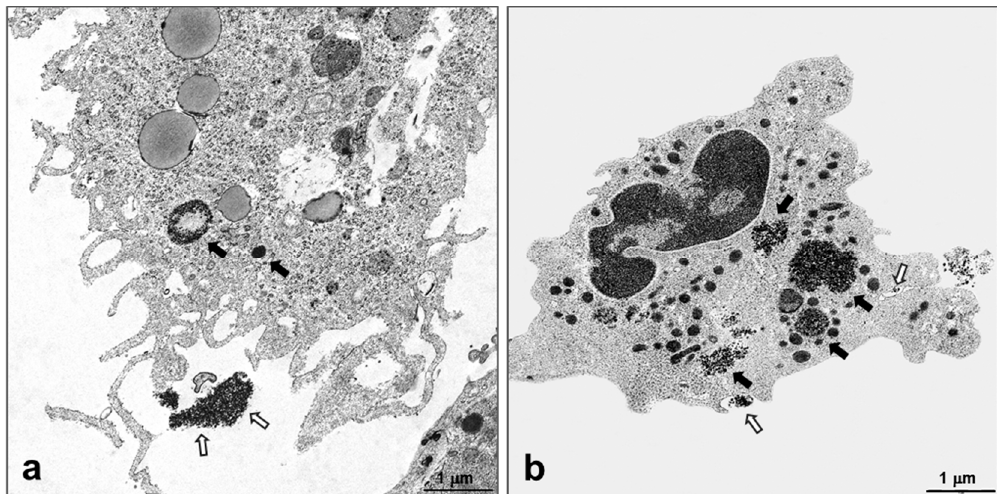
Figure 8 . Localization of SiO 2 NPs in the lungs by transmission electron microscopy. Representative electron micrograph of necrotic lung macrophage ( a ) and activated polymorphonuclear granulocyte ( b ) from NS lung exposed to SiO 2 plain analyzed 5 days after SiO 2 NPs instillation and OVA challenge. SiO 2 NPs were present in vesicles within the cytoplasm (arrows) and outside of the cell (open arrows).